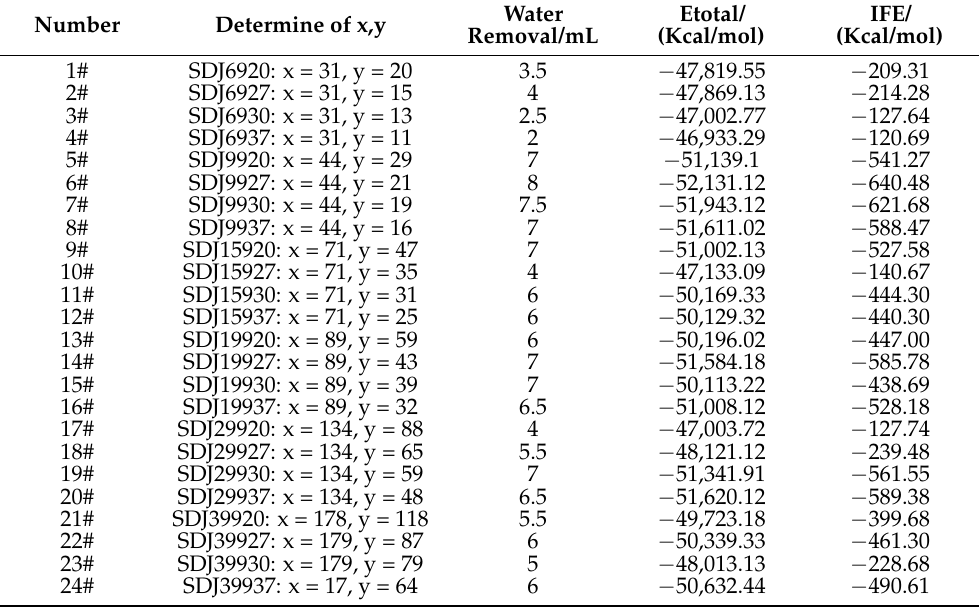
Table 2. Interfacial generation energy of